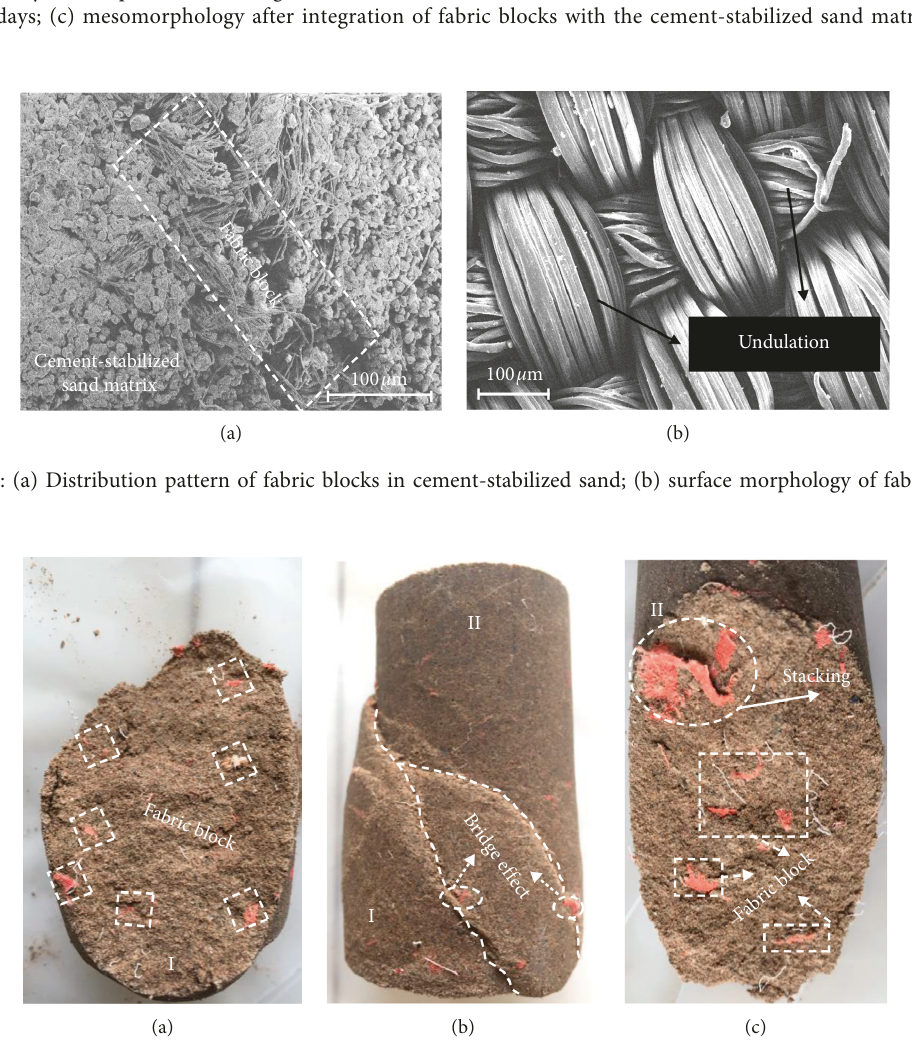
Figure 15: Shear failure surface morphology and distribution of fabric blocks on the failure surface: (a) shear failure surface—part I; (b) whole morphology of the sample after the shear failure; (c) shear failure surface—part II.